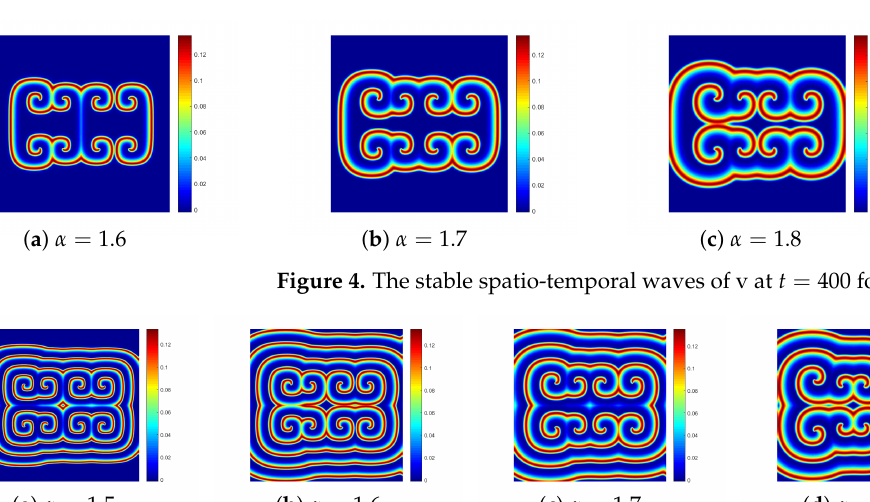
Figure 3. The stable spatio-temporal waves of v at α = 2 and different times for Experiment 2.